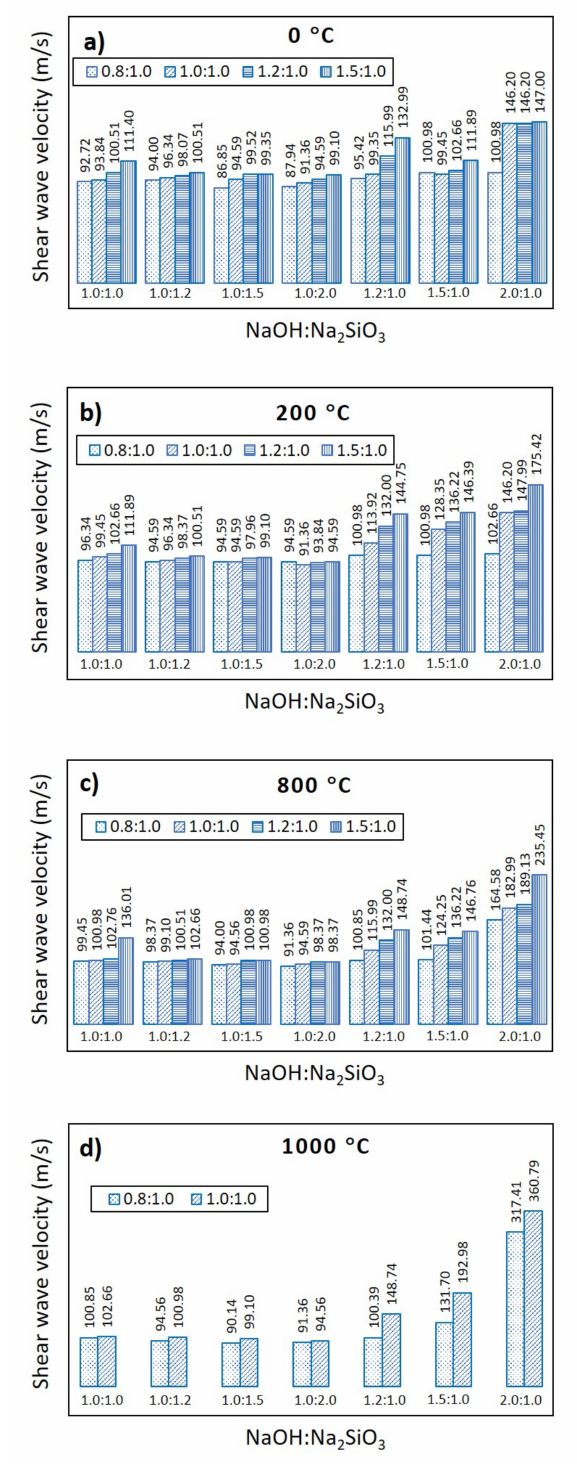
Figure 6. Shear wave velocity vs. NaOH:Na 2 SiO 3 , with various ratios of metakaolin powder and geopolymer solution and various metakaolin treatment temperatures: ( a ) 0 ◦ C; ( b ) 200 ◦ C; ( c ) 800 ◦ C; ( d ) 1000 ◦